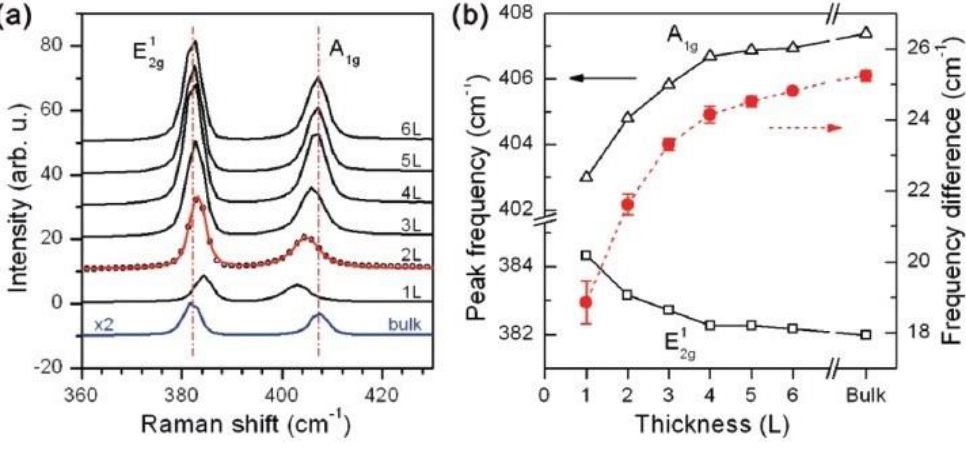
Figure 7. ( a ) Raman spectrum for different thicknesses of MoS 2 . ( b ) Frequencies of A 1g and E 2g1 modes against layer thickness [82]. Reprinted figure with permission from [Lee, C.; Yan, H.; Brus, L.E.; Heinz, T.F.; Hone, J.; Ryu, S. Anomalous lattice vibrations of